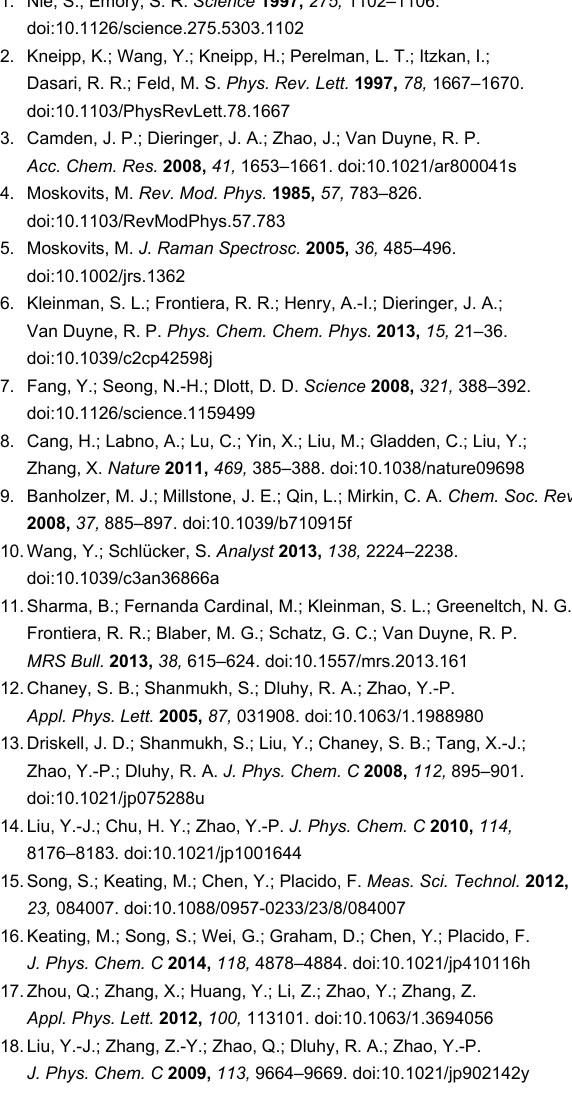
Figure 12: The dependence of EF avg and extinction, absorption and scattering efficiency factors on the diagonal periodicity in the S42 AgNR 2D array with AR = 3.5. The excitation wavelength is 632.8 nm and the polarization is parallel to the y -direction. The dashed lines indi- cate the diagonal periodicity of the ordered array arranged in a regular hexagonal